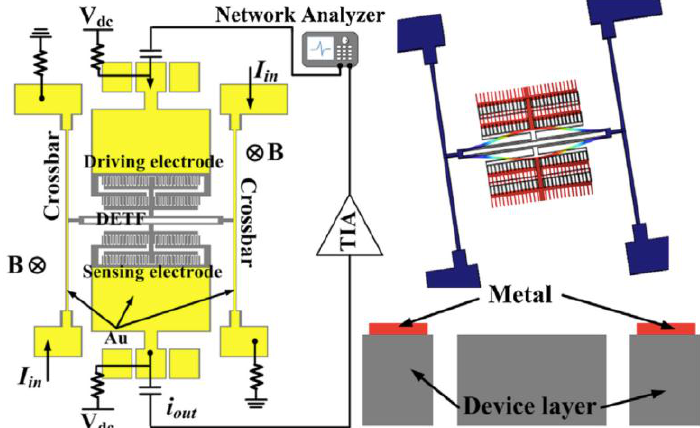
Figure 13. Schematic of a magnetic field sensor formed by a DETF silicon resonator, including the biasing configuration with a transimpedance amplifier (TIA) at the sensing port. The right side depicts the anti-phase vibration mode of the DETF resonator and a cross section schematic view of the sensor [29]. Reprinted with permission from [29]. Copyright© 2014, Elsevier B.V.